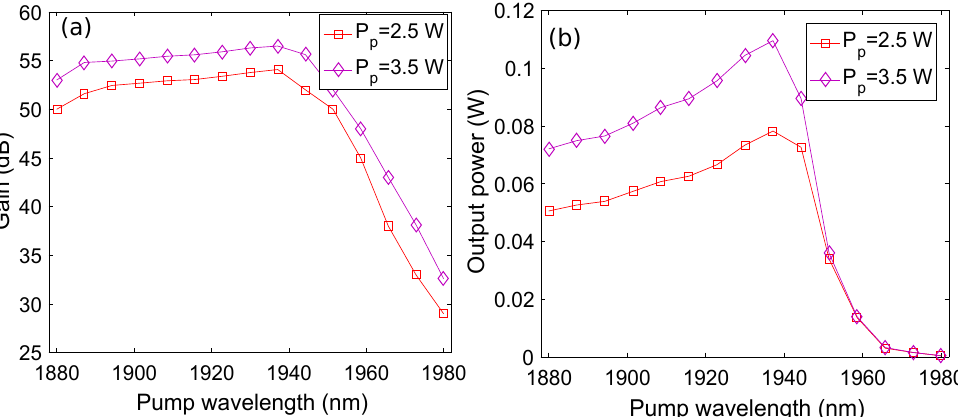
Figure 5. ( a ) Pump wavelength versus gain plots for different values of pump powers and ( b ) Pump wavelength versus output power plots for different values of pump